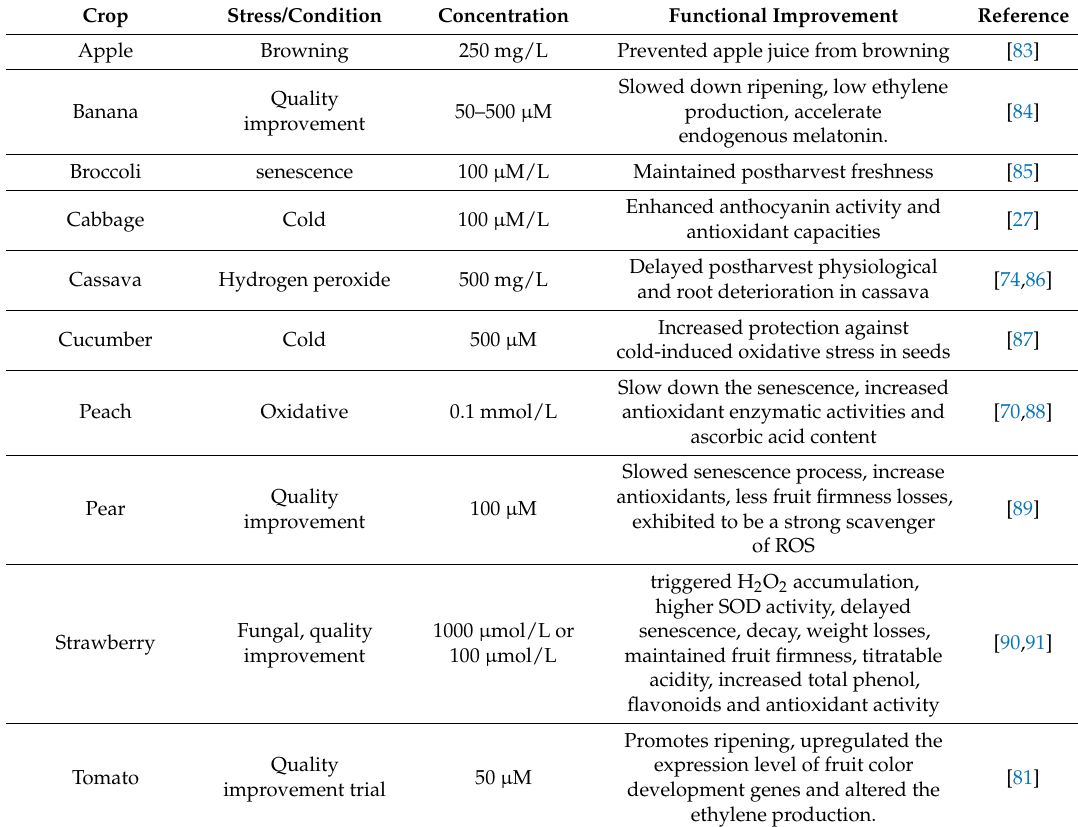
Table 2. Effect of melatonin on postharvest